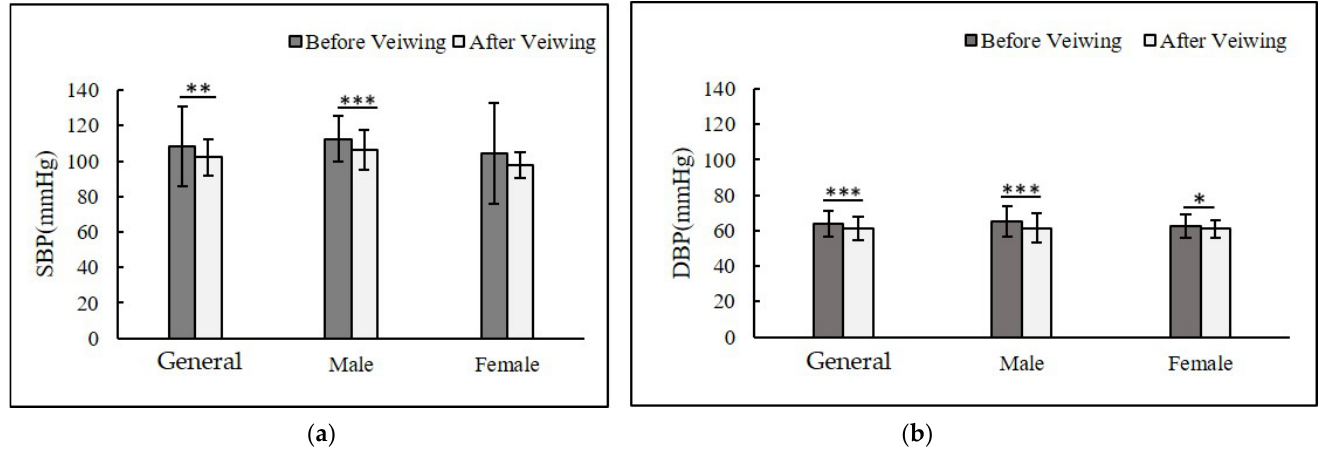
Figure 3. Changes in blood pressure before and after viewing the landscape forest pictures (n = 120; mean ± SD; * p < 0.05; ** p < 0.01; *** p < 0.001; verified by a paired t-test): ( a ) systolic blood pressure changes; ( b ) diastolic blood pressure changes.